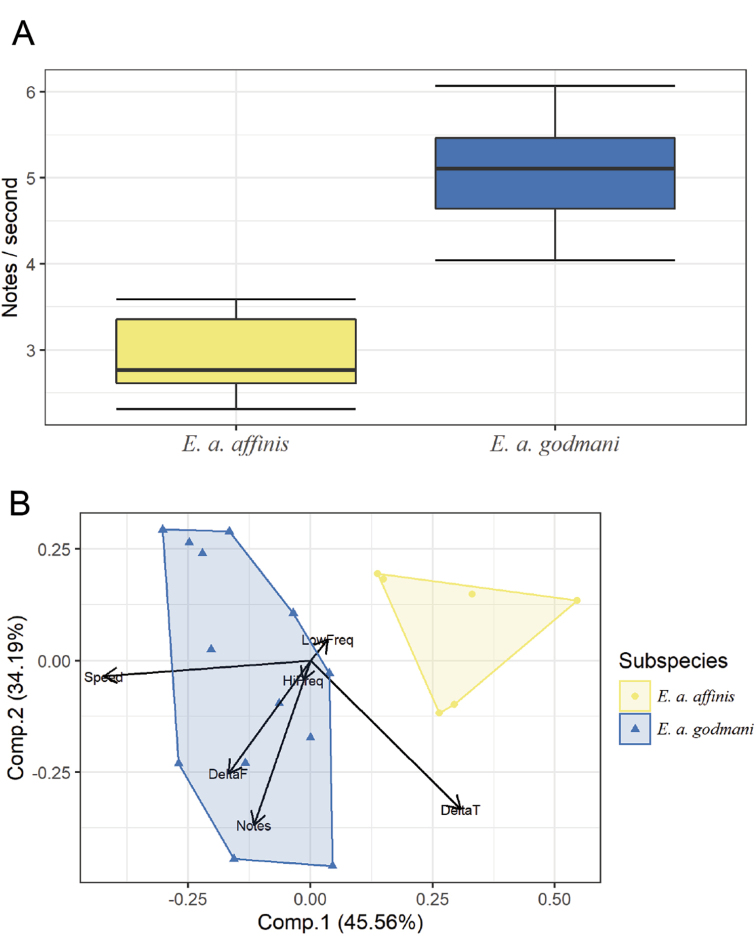
Vocalization analysis. Boxplot of note emission rate A and PCA of measured vocal characters B Calls differ between the two groups in temporal structure, but not in frequency or number of notes.